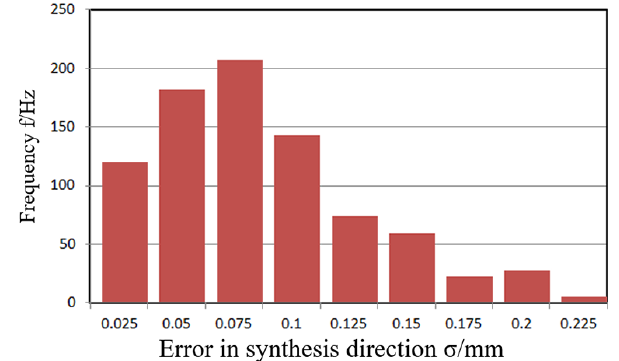
Figure 10. Frequency histogram of position error on working point in (100, 100, 1000) by error independent